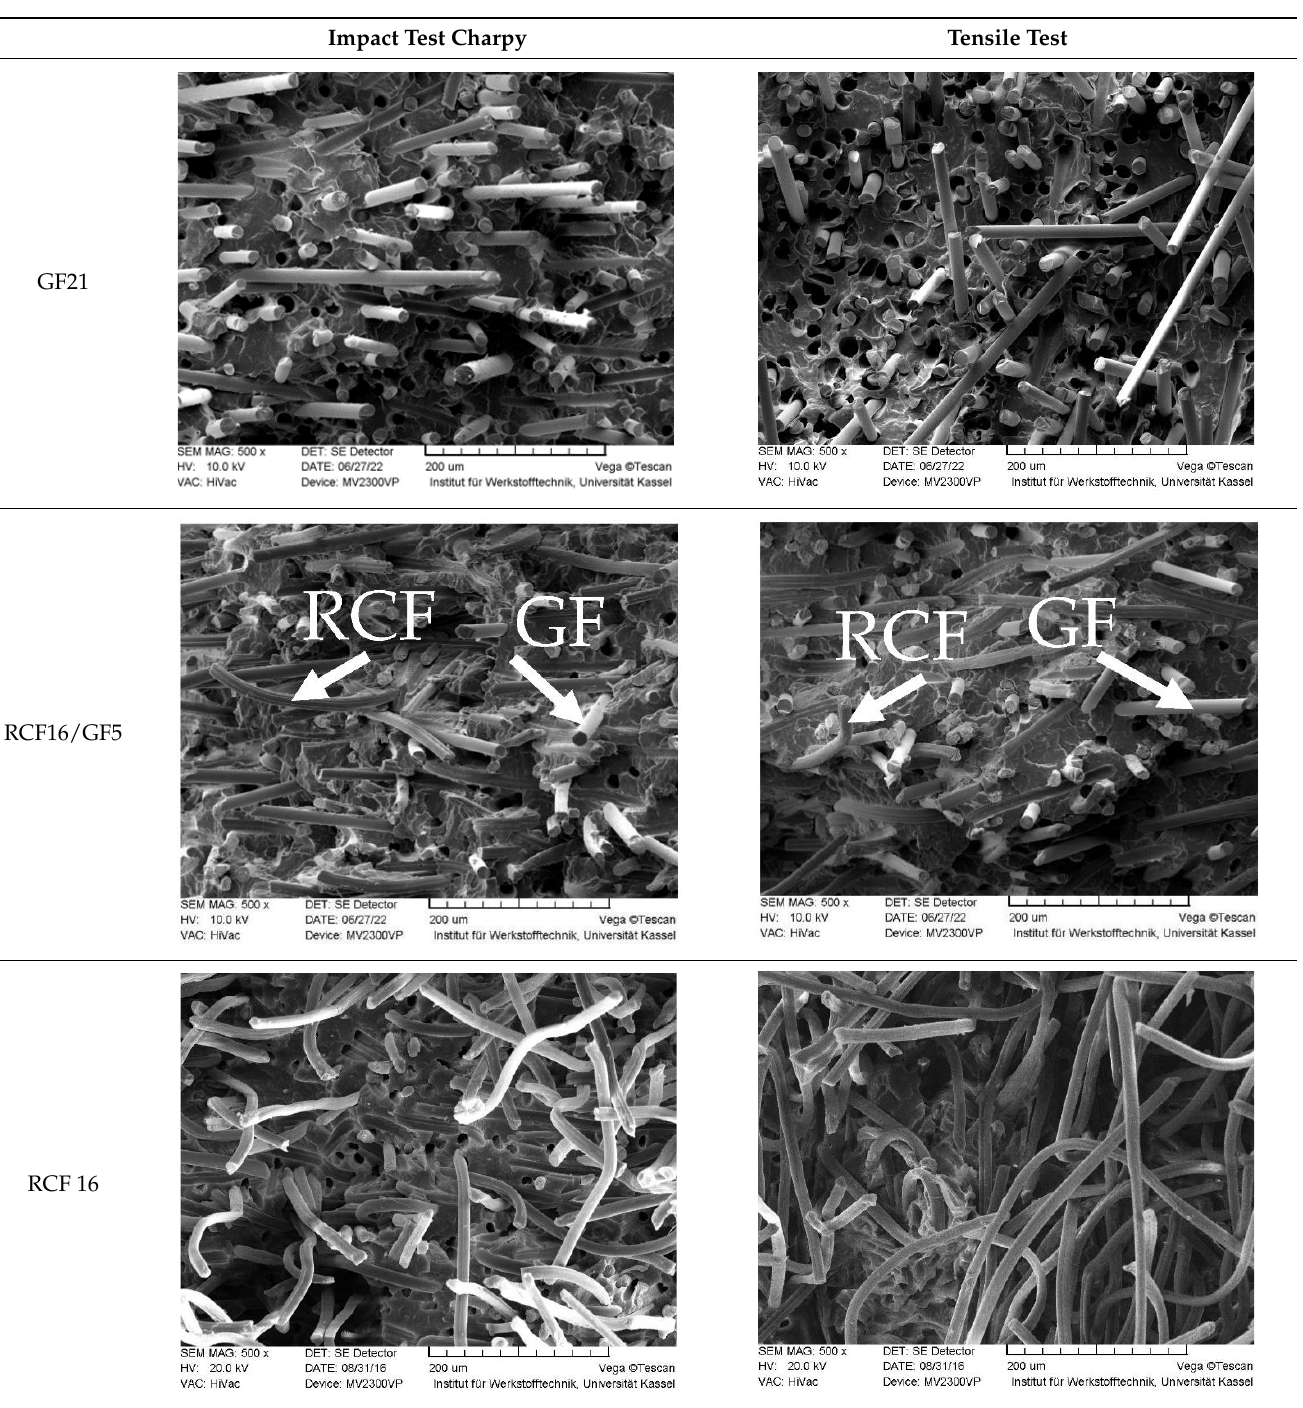
Table 3. SEM Images of reference and hybrid reinforced specimens after tensile or impact test.